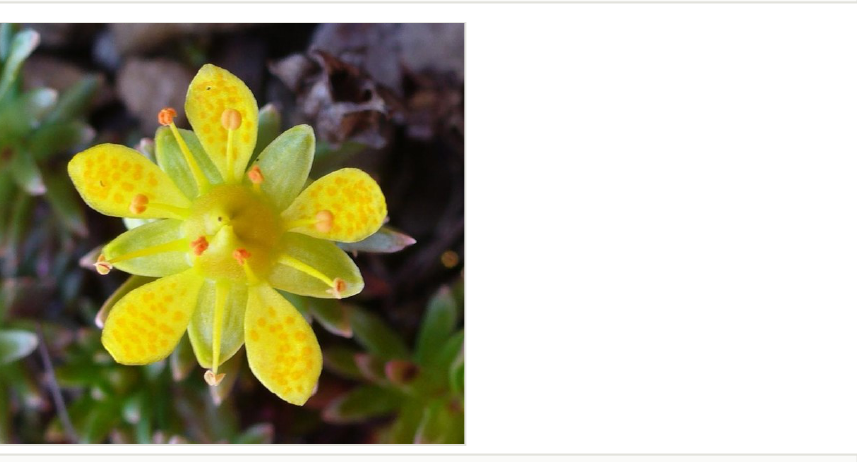
Figure 2. Saxifraga aizoides : the characteristic yellow fl owers punctuated by orange spots on the